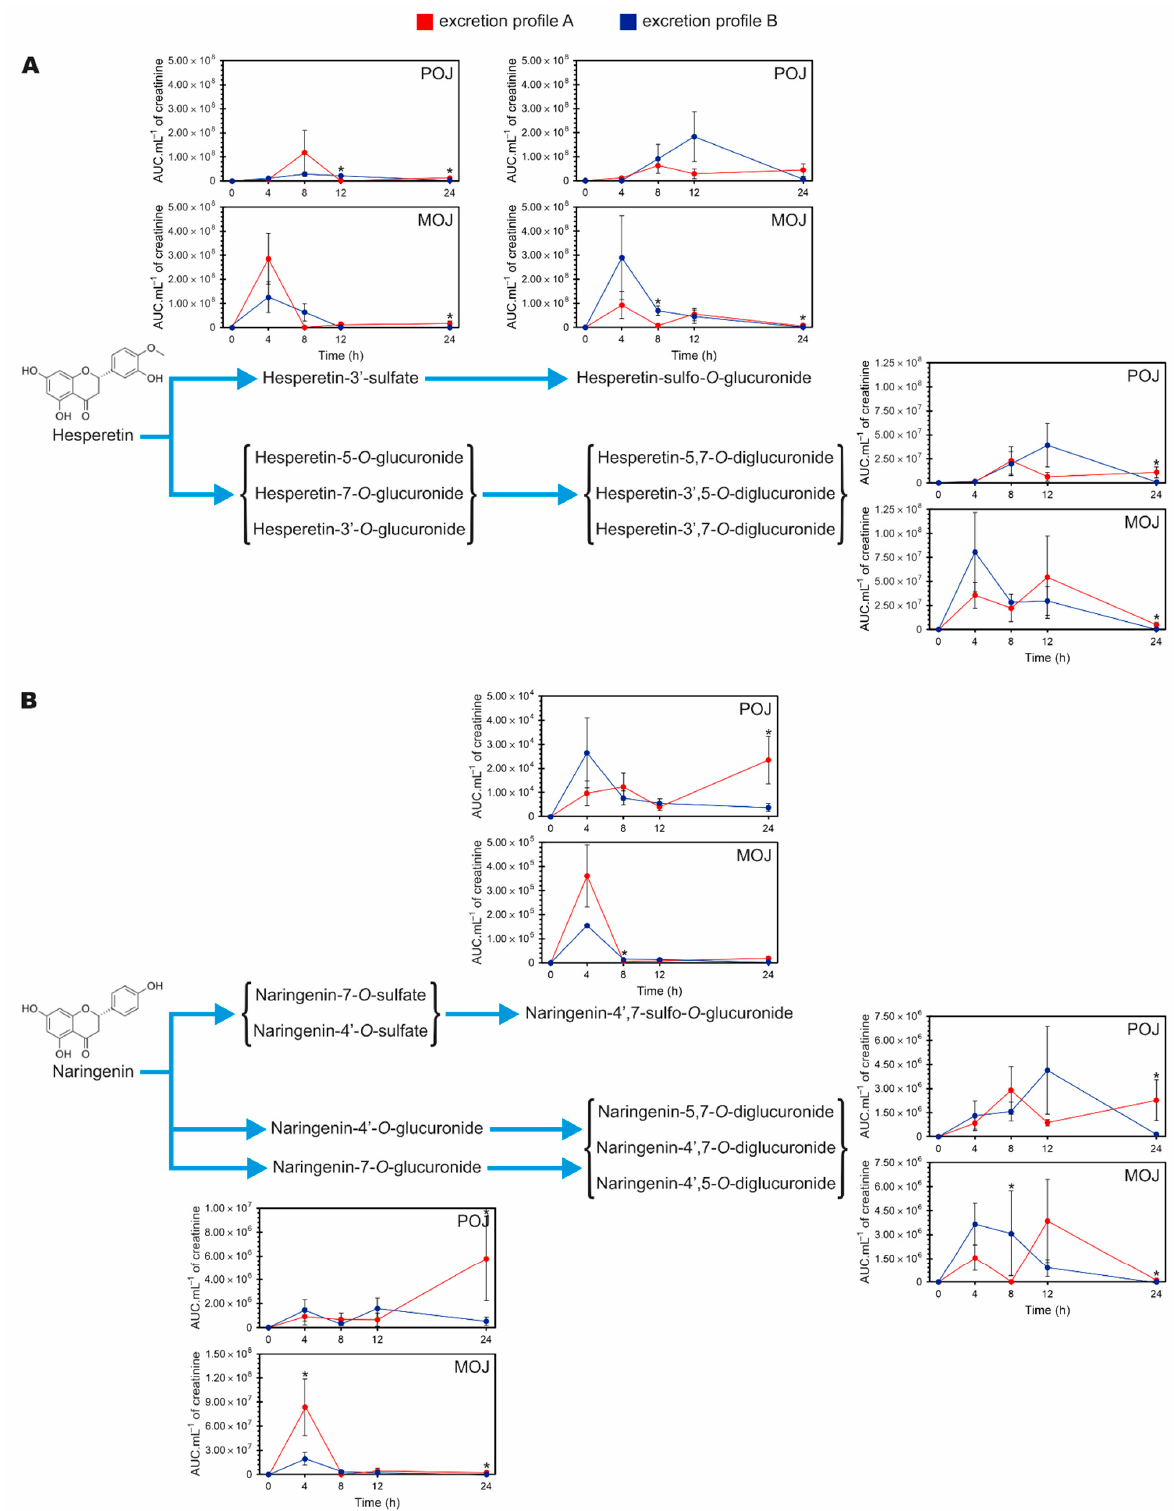
Figure 4. Time course curve of excretion of phase II flavanone metabolites in urine over a 24 h period for individuals classified as having Excretion Profiles A and B after consumption of Pera (POJ) and Moro (MOJ) orange juices: ( A ) Hesperetin metabolites and ( B ) naringenin metabolites. Number of participants: Profile A (n = 10) and Profile B (n = 17) for POJ; Profile A (n = 12) and Profile B (n = 15) for MOJ. Asterisks indicate statistical significance between excretion profiles A and B according to Mann–Whitney test ( p < 0.05). AUC: Area Under the Curve.